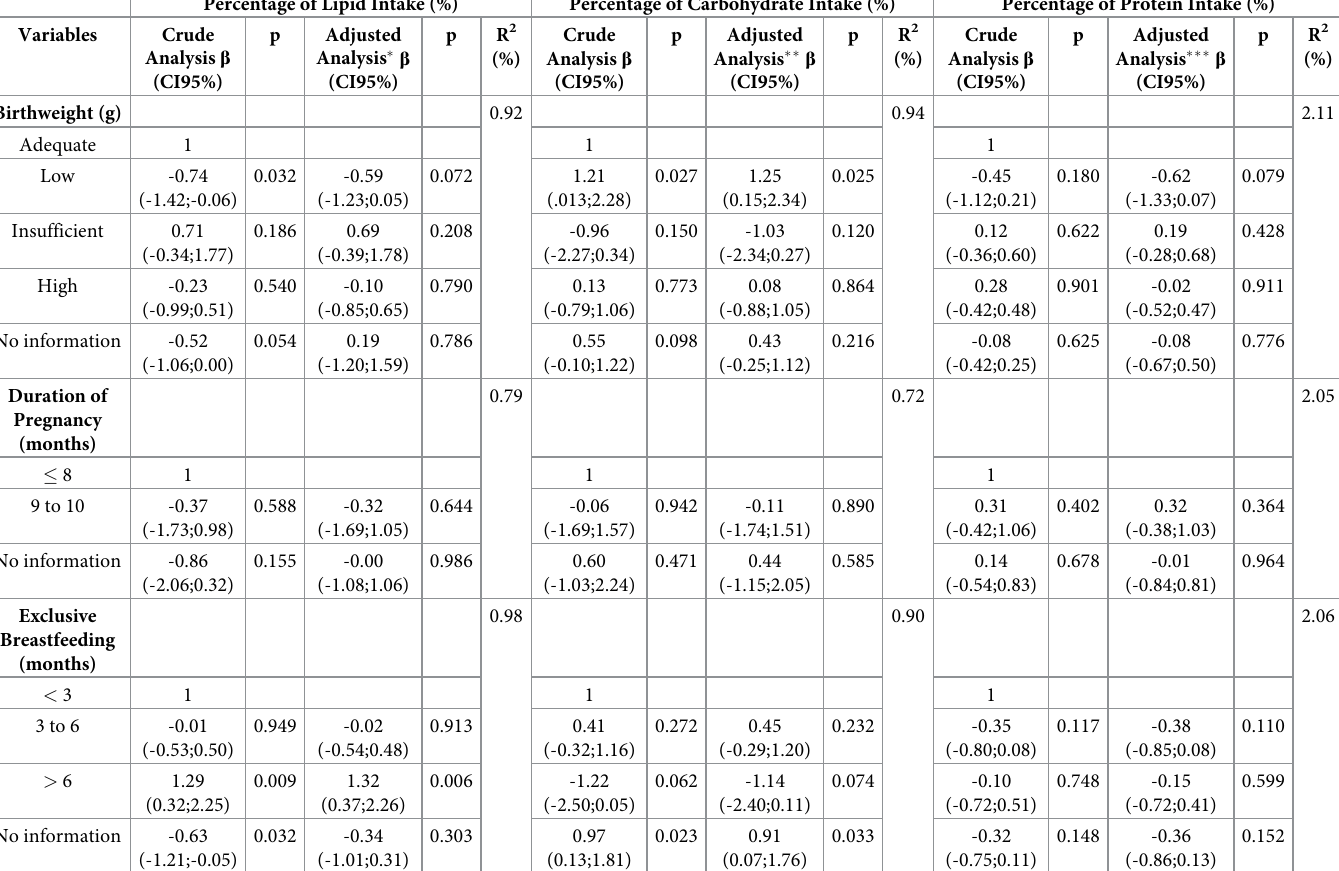
Distribution, Geographic Stratum, Sex, Socioeconomic Class, Nutritional Status, and Sexual Maturity.